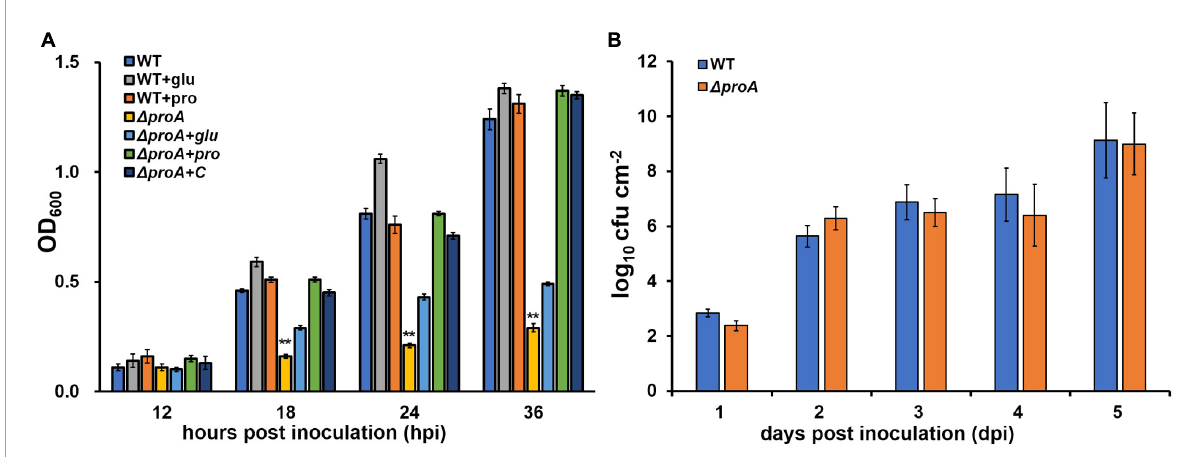
FIGURE1 Involvement of ProA in the growth of R. solanacearum in (A) nutrient-limited sucrose medium (Hoagland medium with 2% sucrose) and (B) intercellular spaces of tobacco leaves. WT, the wild-type strain, RK5050 (OE1-1, popA-lacZYA ); (cid:49) proA , RQ5735 (RK5050, (cid:49) proA ); (cid:49) proA + C, RQC1485 (complementary proA in RQ5735); + glu and + pro, supplemented glutamate at 100 mM or proline at 50 mM in the minimal medium, respectively. For the growth assay in medium, the cell suspension was washed two times with distilled water, adjusted to an OD 600 of 1.0, and inoculated into the minimal medium with a proportion of 1%, and optical density at 600 nm (OD6 00 ) was measured periodically. Each assay was repeated with three biological replicates, including three replicates per trial. For the growth assay in tobacco leaves, which was presented in log cfu cm − 2 , tobacco plants were inoculated with the method of leaf infiltration, and leaf disks (0.38 cm 2 ) were punched and subjected to daily quantification of cell number by dilution plating. The growth assay was carried out till 5 dpi, when tobacco leaves became withered and dried. Each assay was repeated with more than four biological replicates, including six replicates per trial. Mean values of all experiments were averaged and presented with SD (error bars). Statistical significance between proA mutants and the wild-type RK5050, or that between treatments with supplementation or without supplementation, was assessed using a post-hoc Dunnett test following ANOVA. Significance level, ** indicates P <